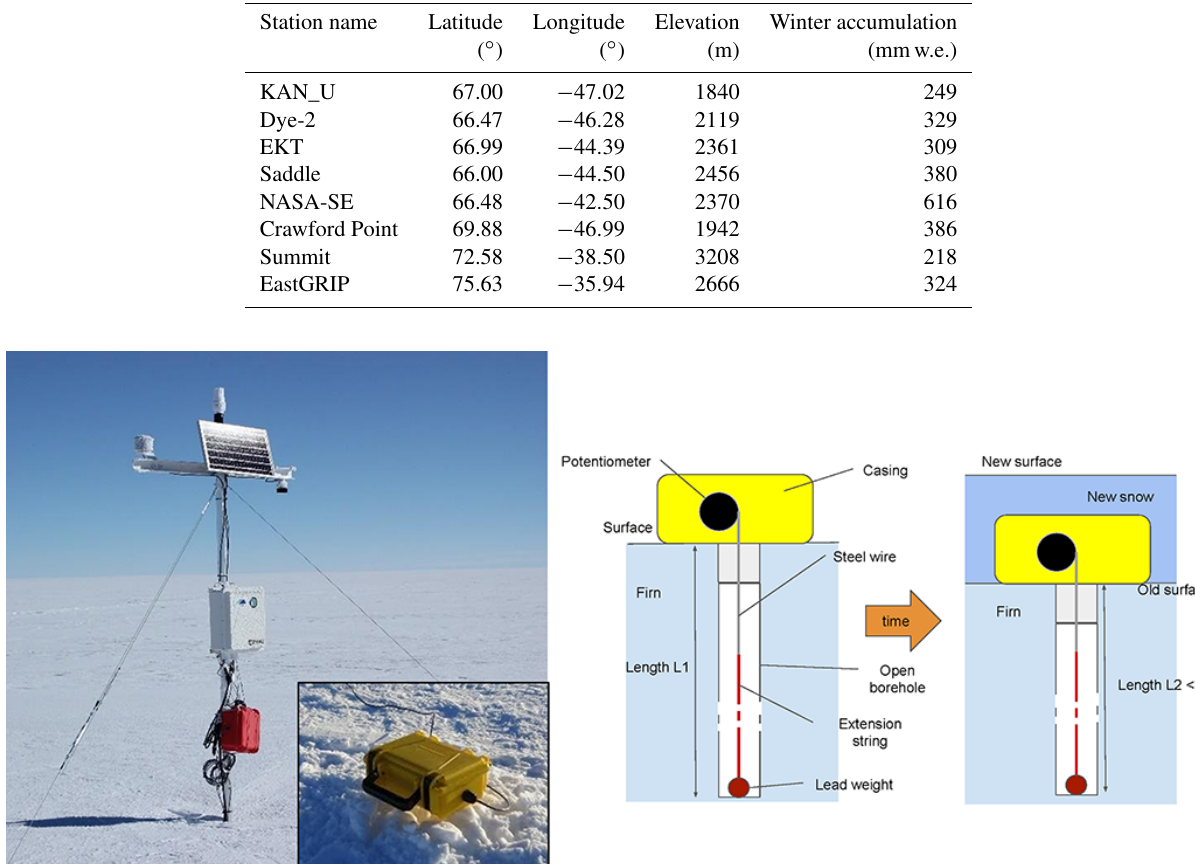
Figure 2. FirnCover station (left), strainmeter casing (inset), and strainmeter conceptual design (right).